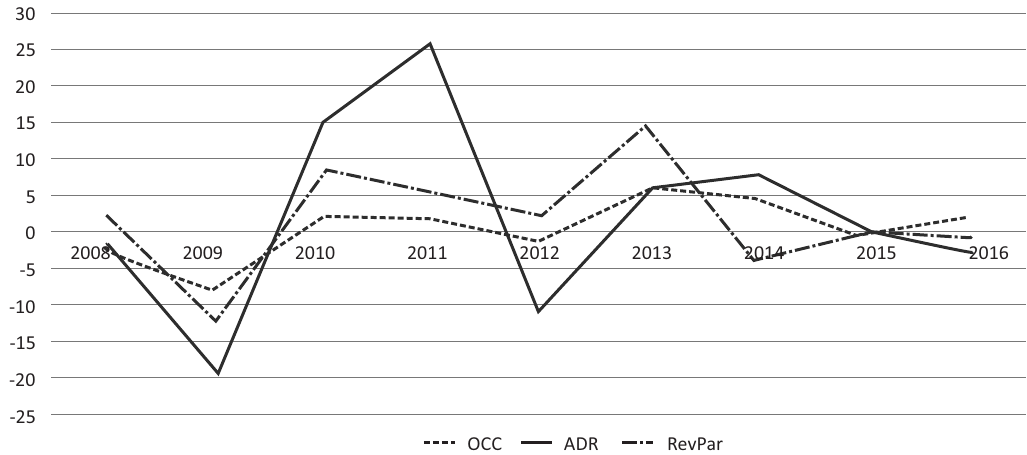
Figure 3. Changes in main hotel KPI’s at Marriott International Inc. in 2008–2016, %